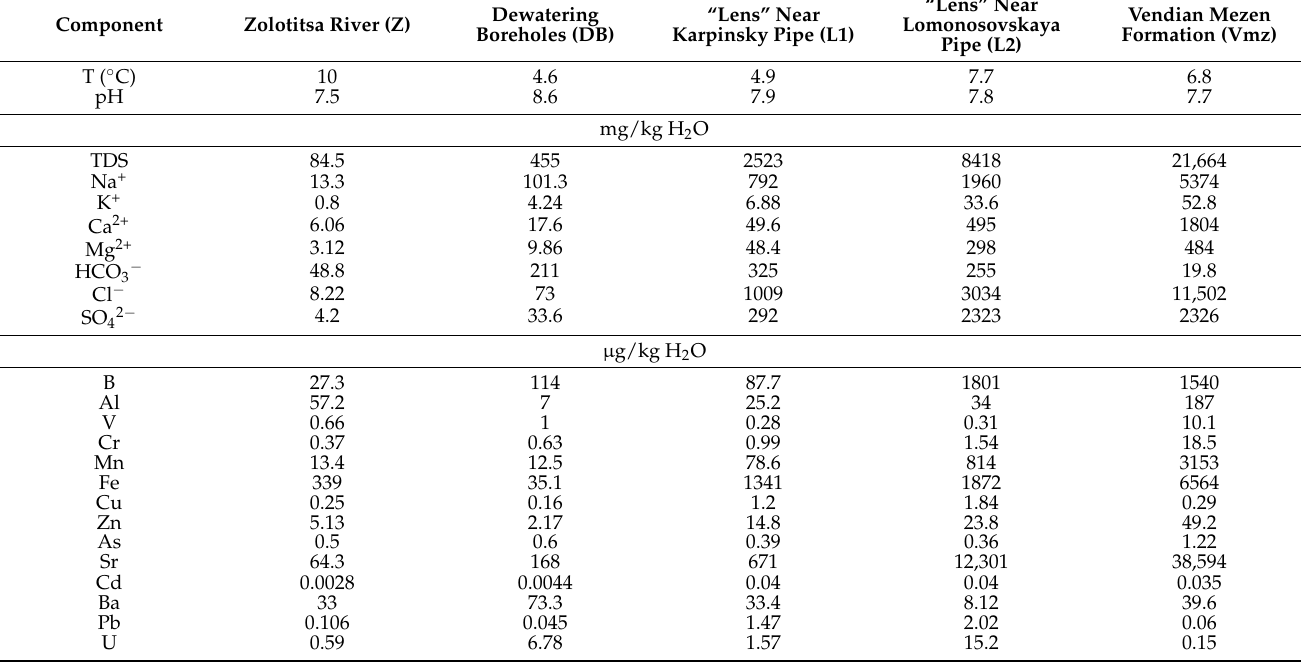
Table 2. Initial composition of surface water and groundwater taken in modeling their